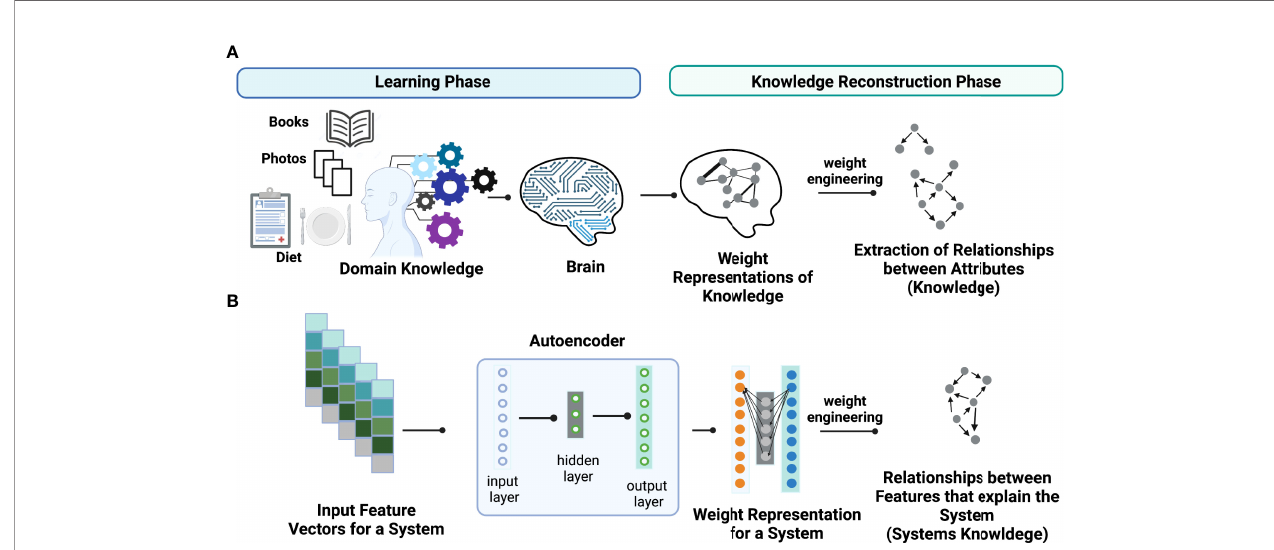
FIGURE 1 | Conceptual illustration of learned knowledge. Weight engineering is utilized to extract meaningful learned knowledge by a learner such as (A) the human brain and (B) an arti fi cial neural network (ANN) model including an autoencoder. During the learning process, the learner (brain or ANN) translates the learned associations between attributes or features that explain the property of a system, that we call “ knowledge ” , into weight representations that are stored as synaptic strengths in the brain or interneuronal weights in an ANN model. Weight engineering, a mathematical approach that manipulates learned weights stored from a learner, reconstructs the learned knowledge by decoding associations between features (i.e., gene-gene interactions) that can explain the properties of a desired system. Figure generated with